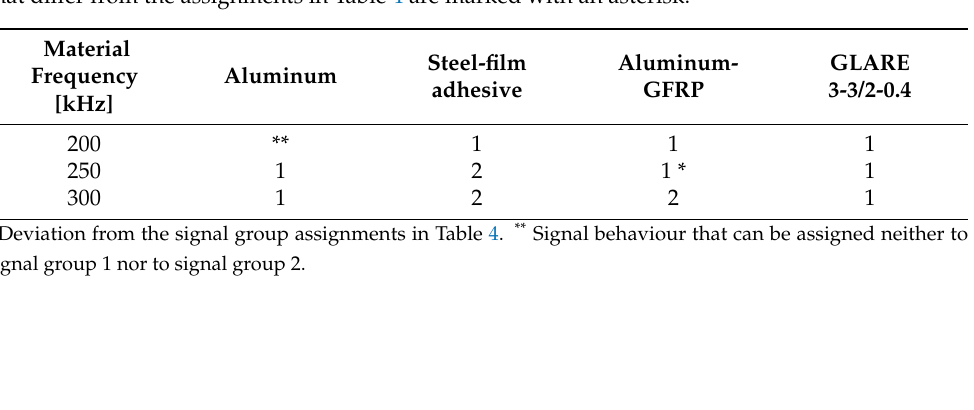
Table 6. Overview of the APDS-STFT assignment into signal group 1 and signal group 2. Positions that differ from the assignments in Table 4 are marked with an